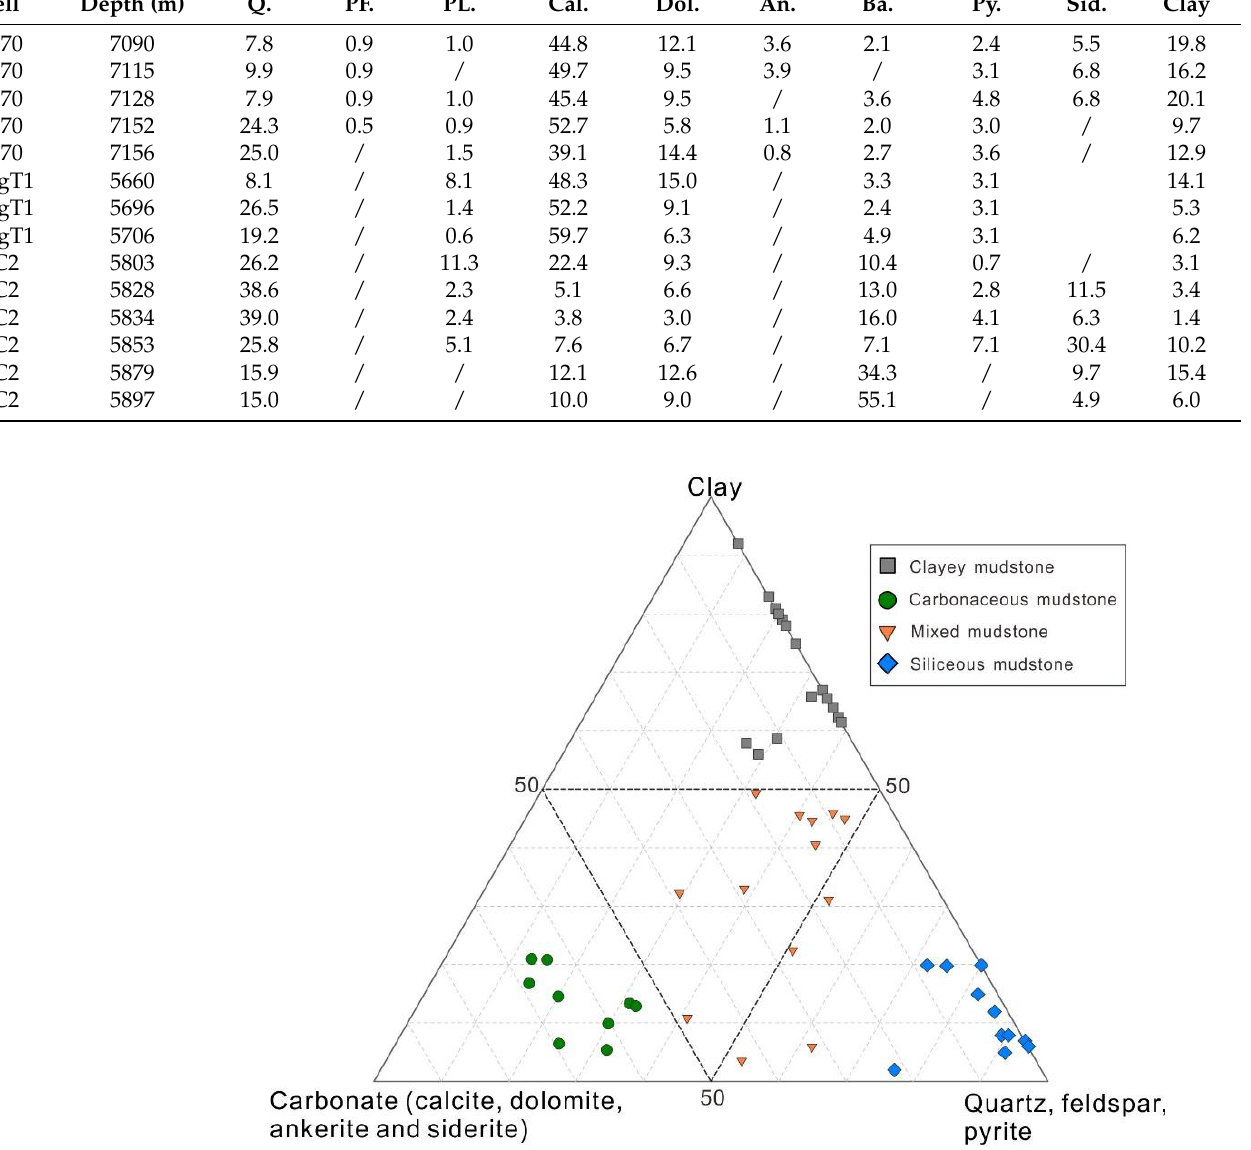
Figure 3. Clay–carbonate–rigid particles (quartz, feldspar and pyrite) minerals ternary diagram and lithofacies types classification of the Longtan Formation.